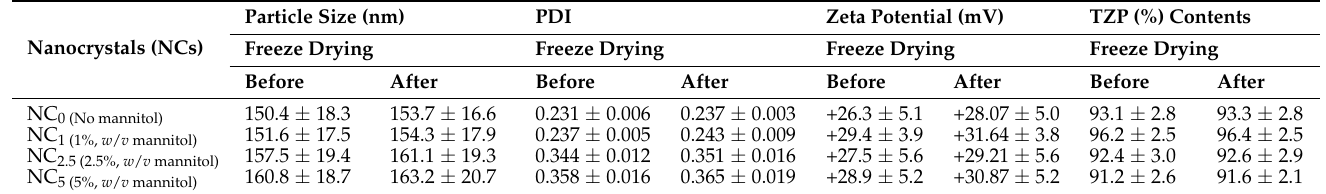
Table 3. Physical characterization and drug content of the different preparations of NCs-3 (TZP 10 mg and P188 at 1%, w / v ) with Benzalkonium chloride (0.01%, w / v ), stearylamine (0.2%, w / v of total formulation) and varying concentrations of mannitol (Mean ± SD, n =